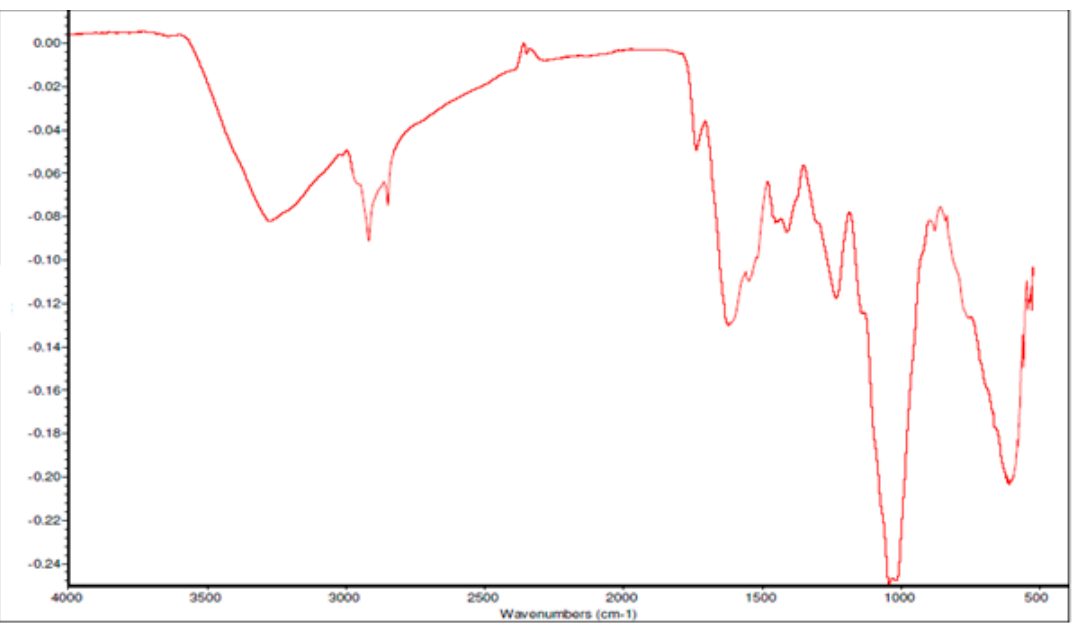
Figure 4. Fourier Transform Infrared spectroscopy (FTIR) spectrum of ZrO 2 nanoparticles.